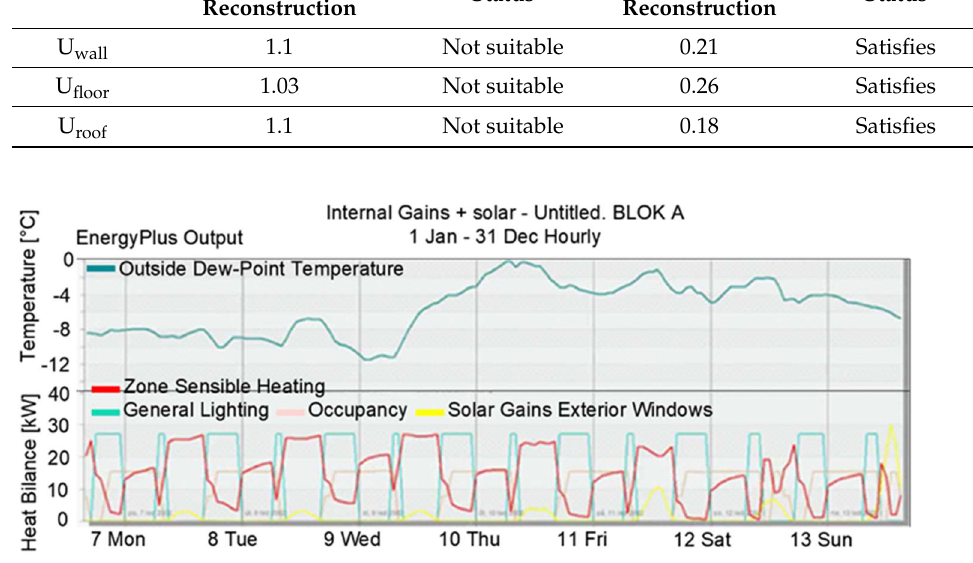
Figure 14. Heat balance of Block A before the reconstruction in winter (weekly section).